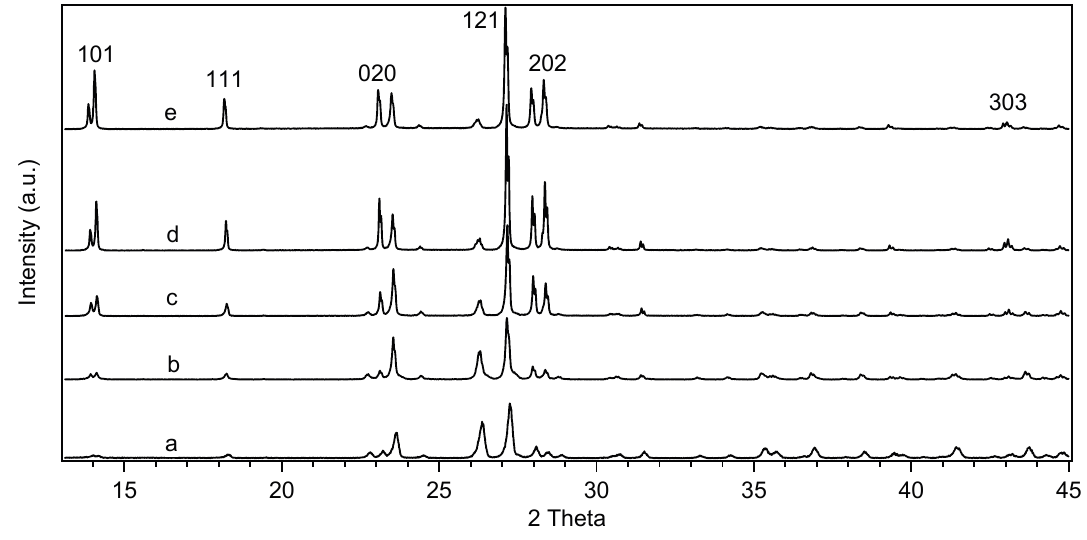
Figure 4. Powder X-ray diffractograms of HI 3 O 8 in various forms normalized by total area: ( a ) HI 3 O 8 , as received material; ( b ) drop casted film; and ( c – e ) spin coated films at 500 rpm, 1500 rpm, and 2500 rpm. Films were deposited at ~2% relative humidity from a sonicated suspension of the as received material in denatured